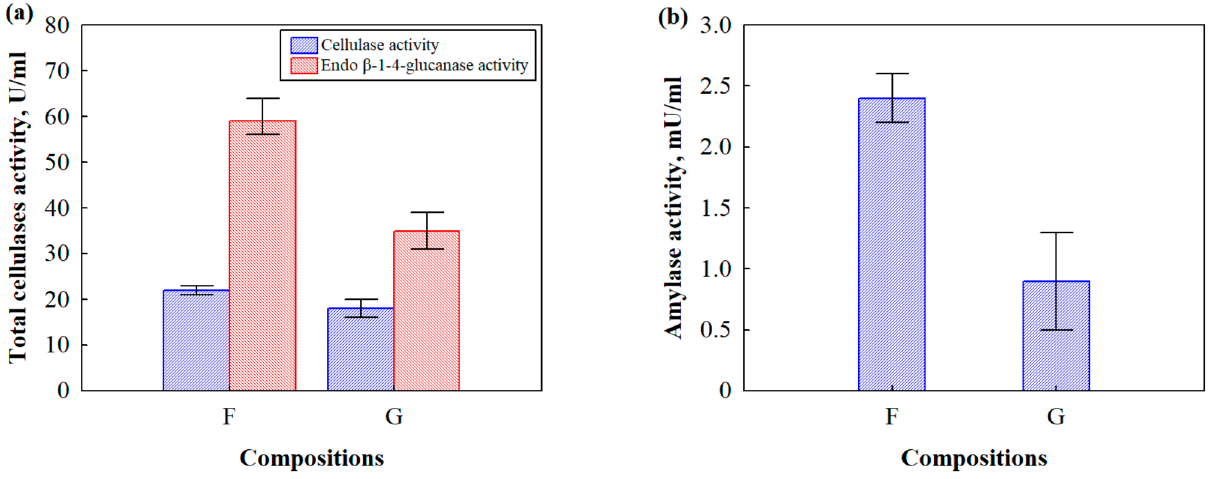
Figure 4. Total enzymatic activities of the microorganisms after growth on BcBs with different flame retardants: ( a ) cellulase activity; ( b ) amylase activity. All measurements were in triplicate; the average values and standard deviations are given.